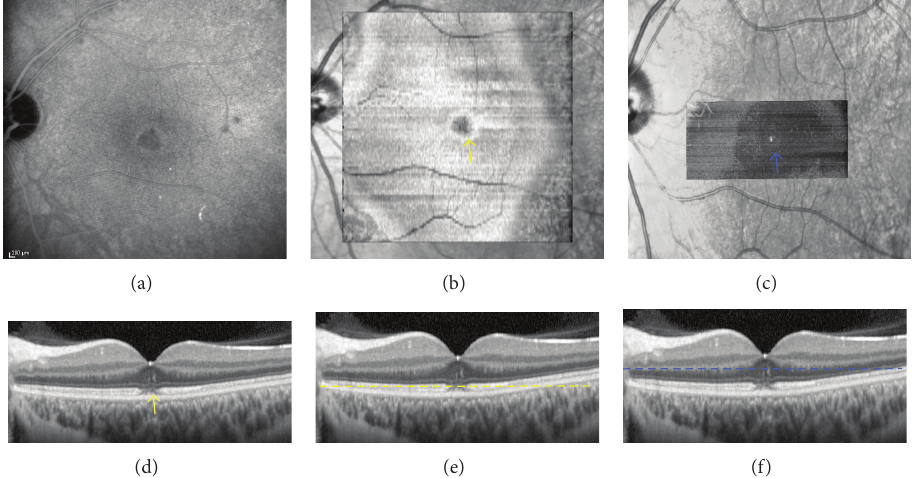
Figure 5: Patient 2. (a) Indocyanine green angiography (20minutes), ((b)-(c)) “en-face” and ((d)–(f)) B-scan SD-OCT, at the initial visit, showing a cockade-like lesion in the macular area and a hyperreflective lesion between the RPE and IS-OS junction (yellow and blue